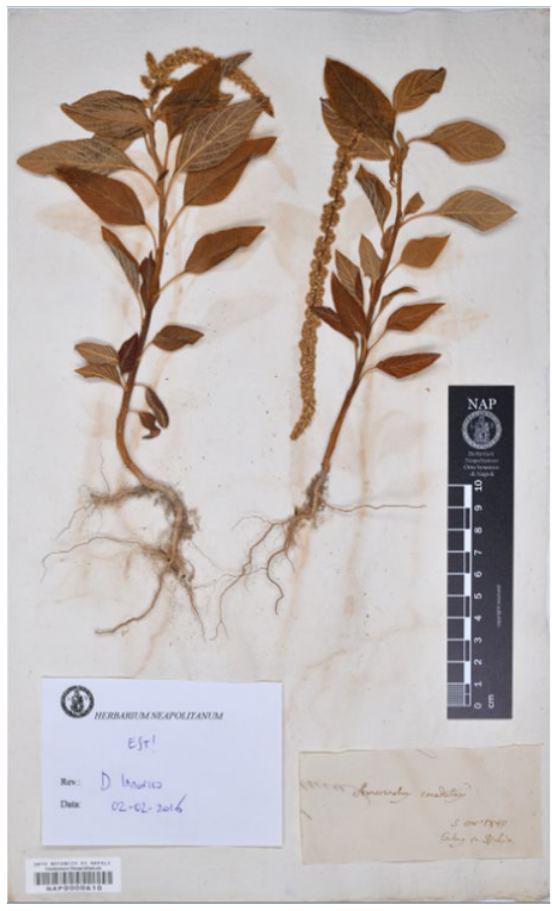
Figure 6. Neotype of the name Amaranthus dussii (NAP0000610!).